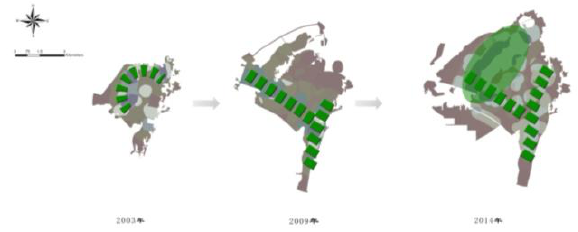
Figure 6. Spatial structure Evolution of Ecological performance in Guyuan